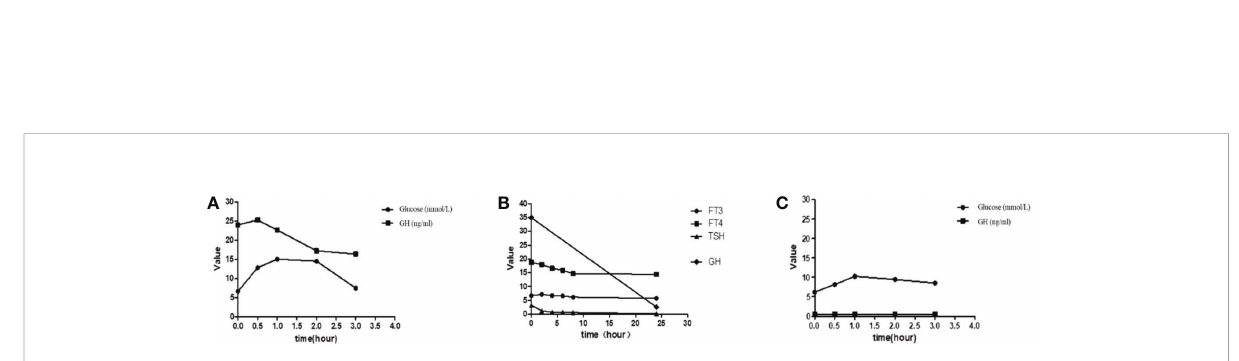
The 4th month after surgery